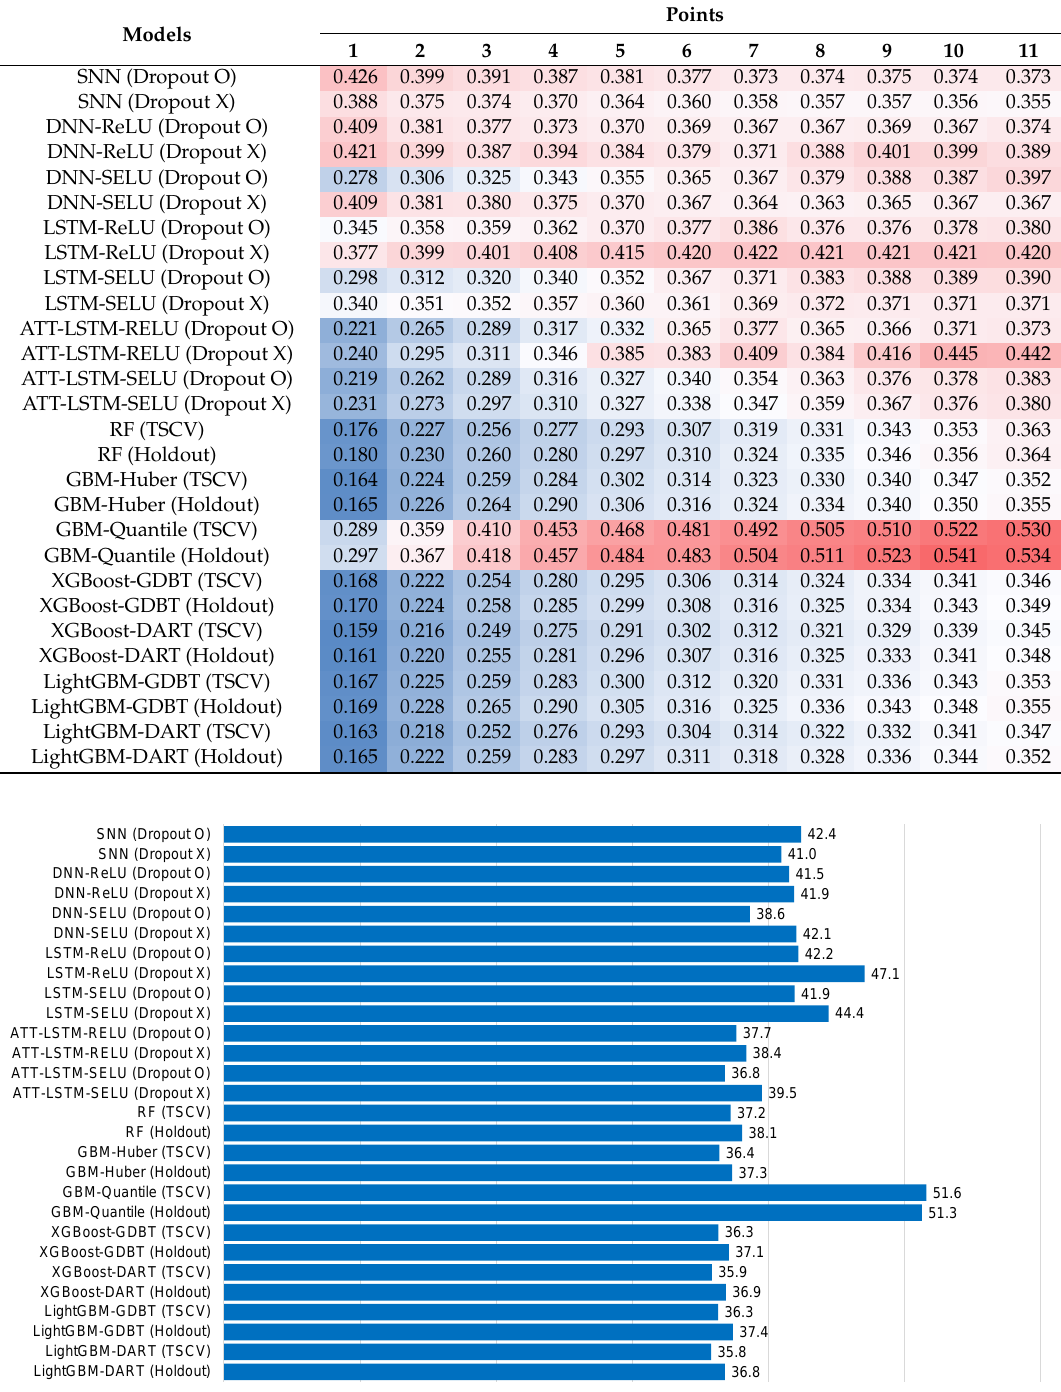
Table 10. Mean absolute error (MAE) distribution for each model of Gosan-ri. A cooler color indicates a lower MAE value, whereas a warmer color indicates a higher MAE value (MJ/m 2 ).